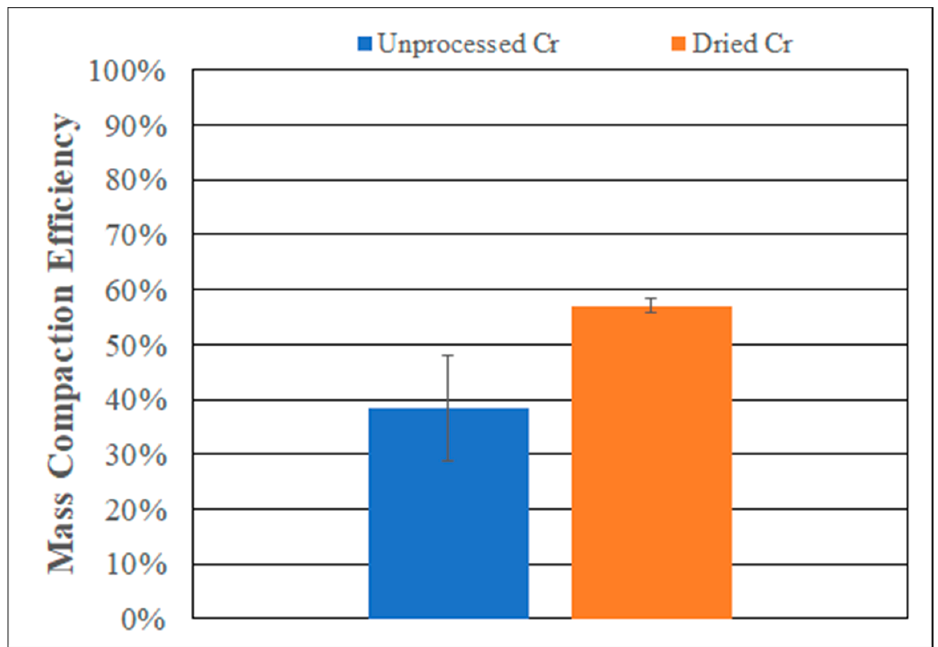
Figure 16. Percent mass compaction data of impacted green bodies for evaluated Cr powders.